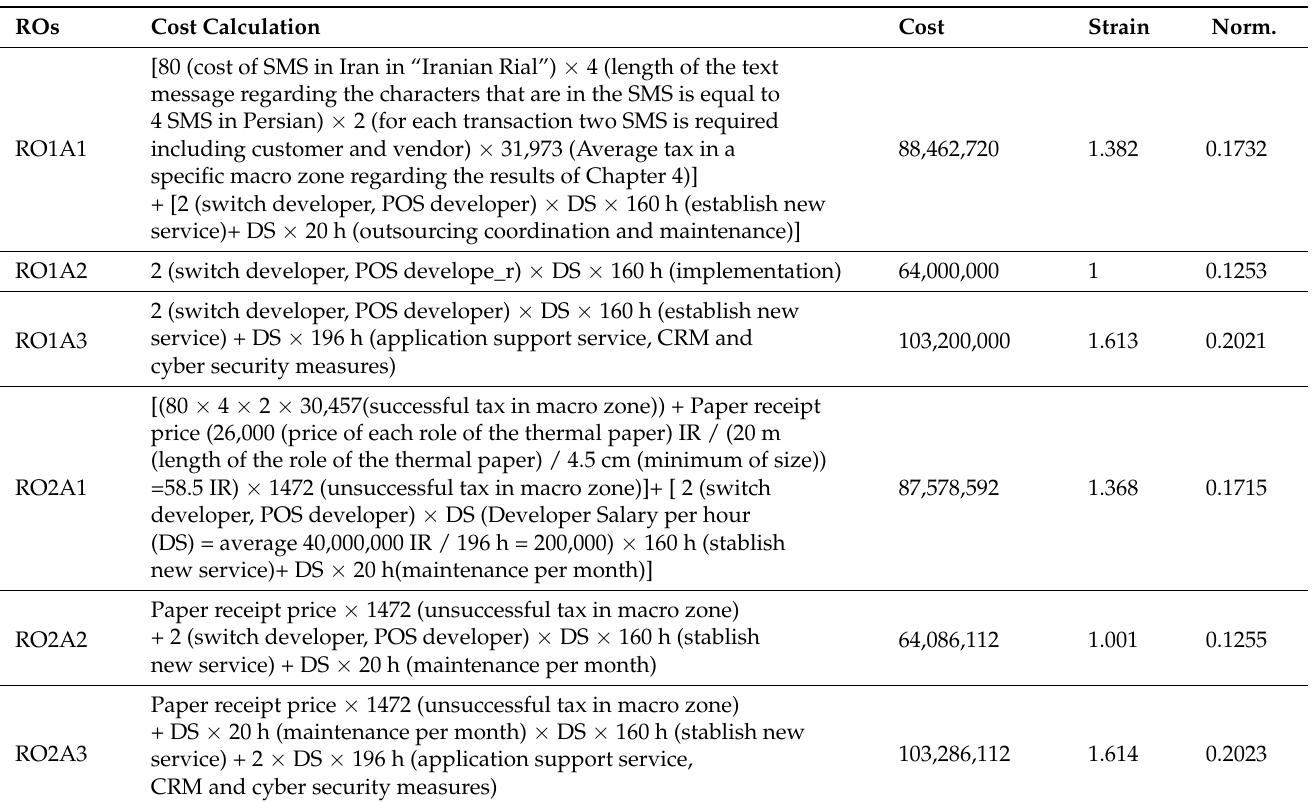
Table 5. Strain calculation